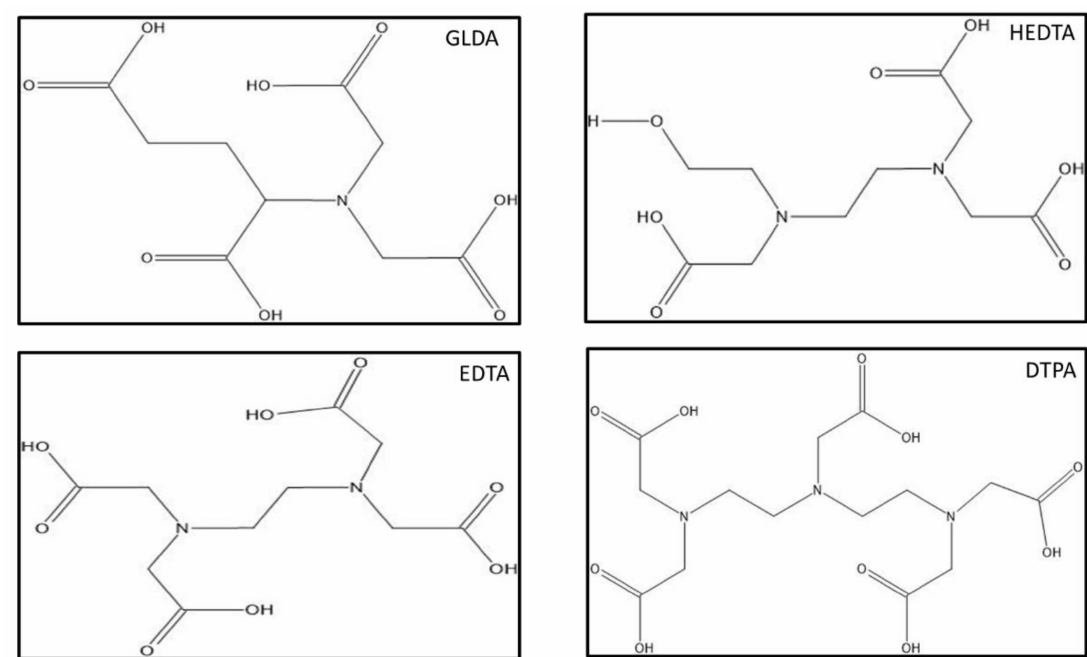
Figure 1. Chemical structure of different chelating